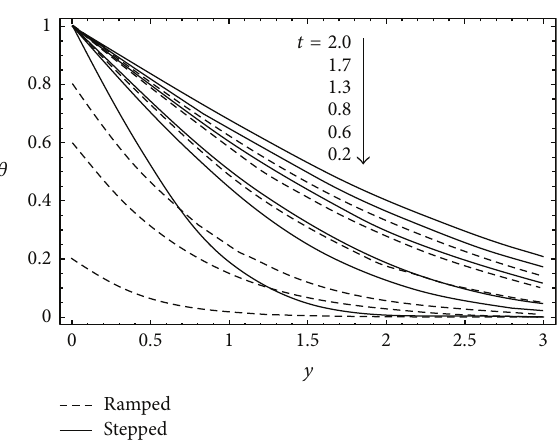
Figure 5: Velocity profiles for different values of 𝑡 .